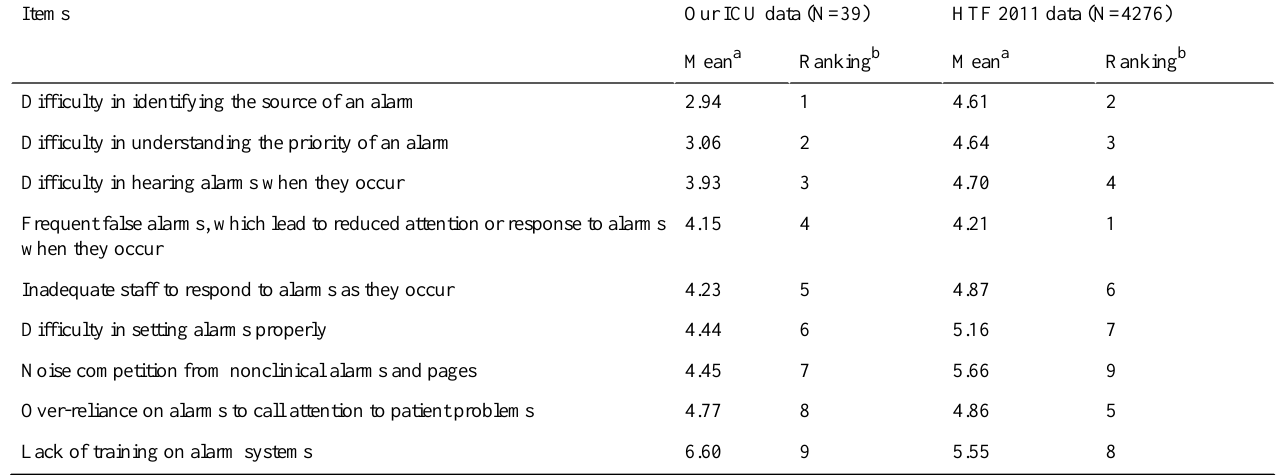
Table 3. Ranking of TCICU nurses compared to respondents of the 2011 HTF clinical alarms survey on the importance of issues that affect response to alarms (1=most important, 9=least important).